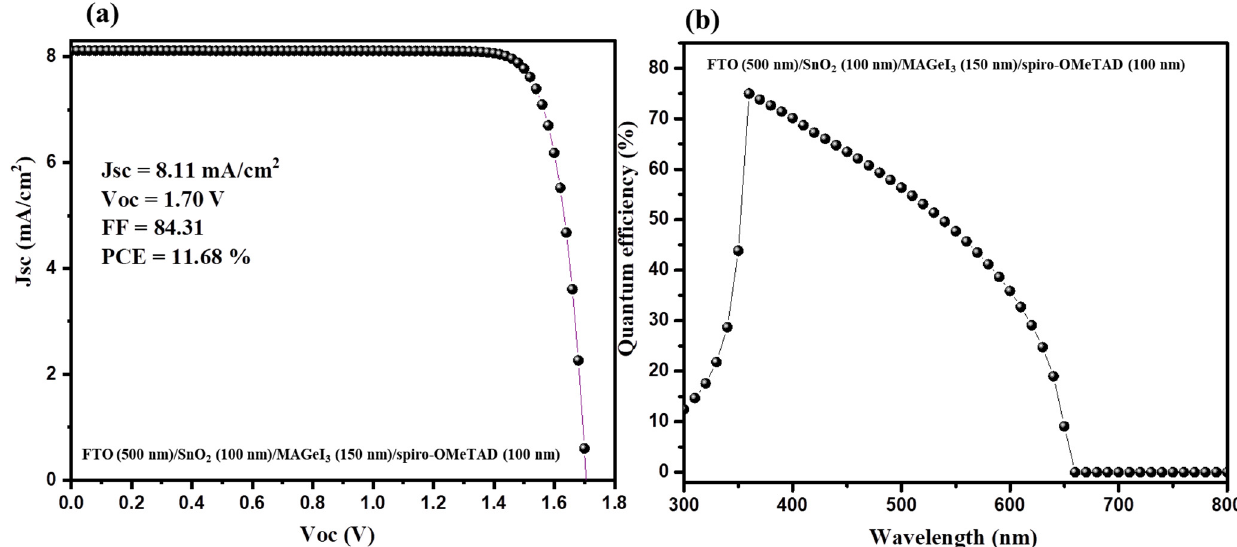
Figure 1. J-V curve ( a ) and EQE curve ( b ) of the simulated PSCs (FTO(500 nm)/SnO 2 (100 nm)/MAGeI 3 (150 nm)/spiro-OMeTAD(100 nm)) at 300 K. The poor Jsc of the simulated PSCs (FTO(500 nm)/SnO 2 (100 nm)/MAGeI 3 (150 nm)/spiro-OMeTAD(100 nm)) was due to poor quantum efficiency. In some cases, tem-